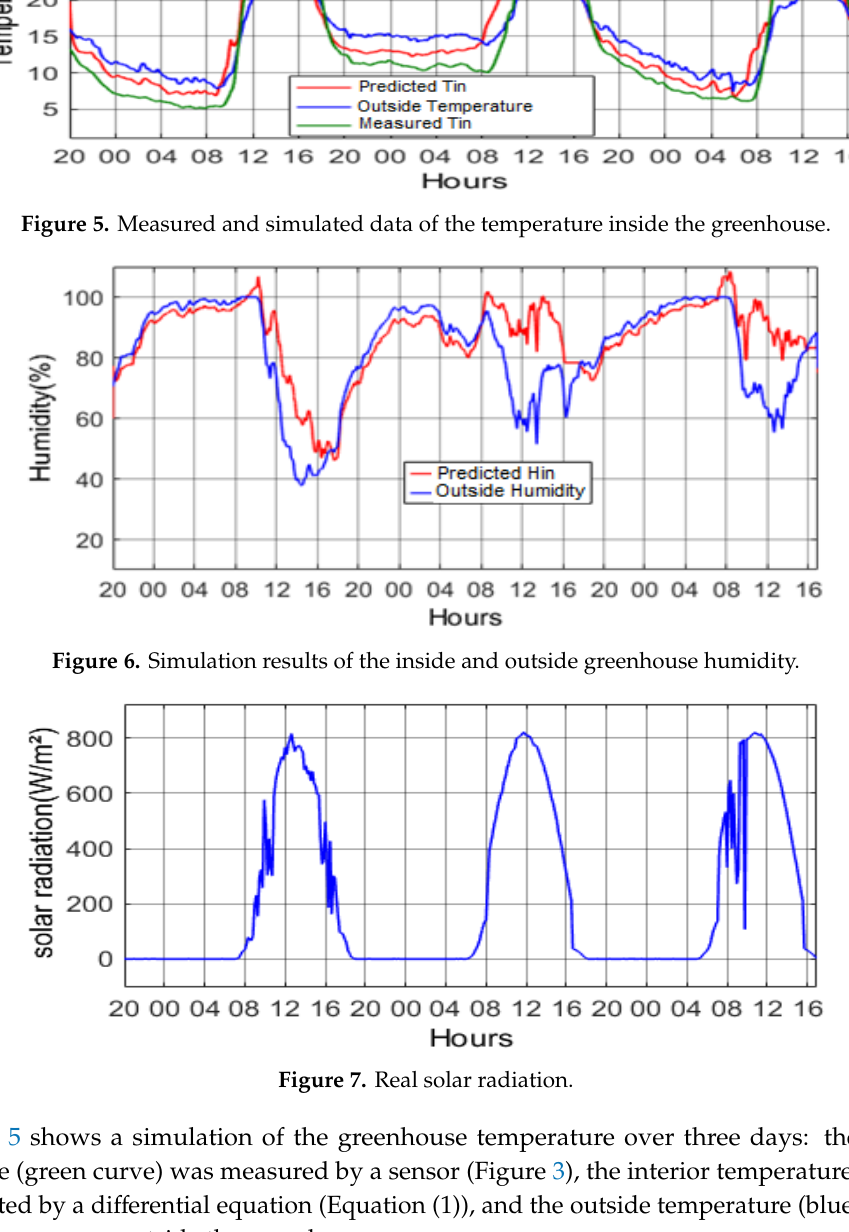
Figure 5. Measured and simulated data of the temperature inside the greenhouse.